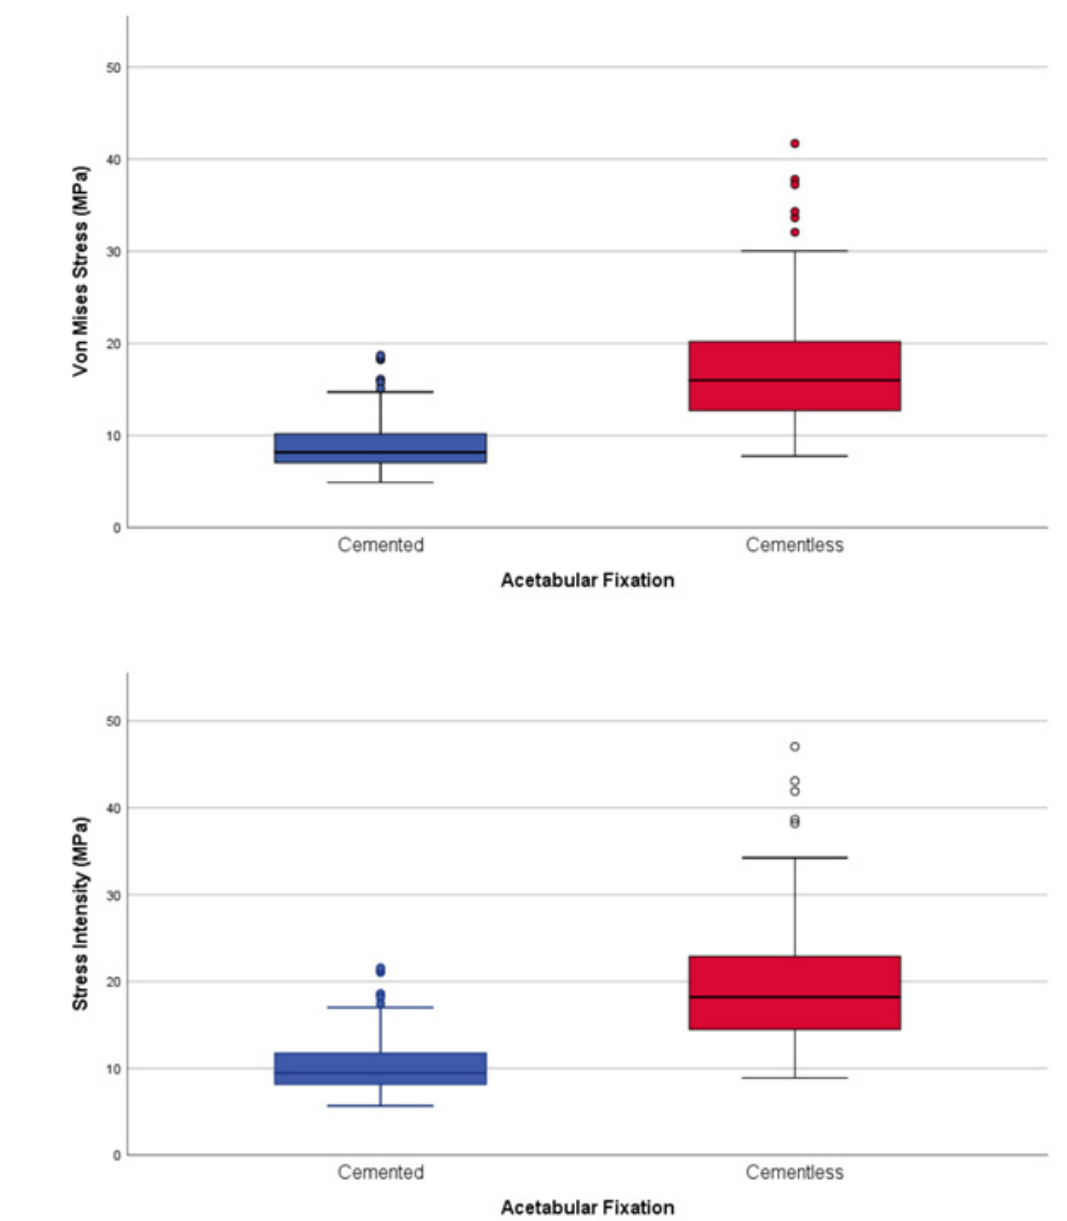
Figure 5. Acetabular Fixation wear risk based on stresses; ( a ) VM Stress; ( b ) SI stress.